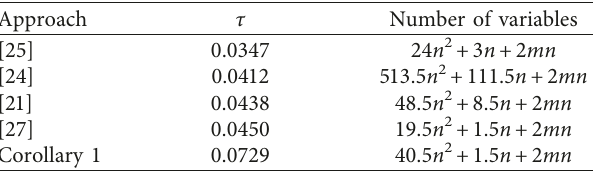
Table 2: Largest sampling interval τ with different approaches.